Question: What form of chart is displayed?
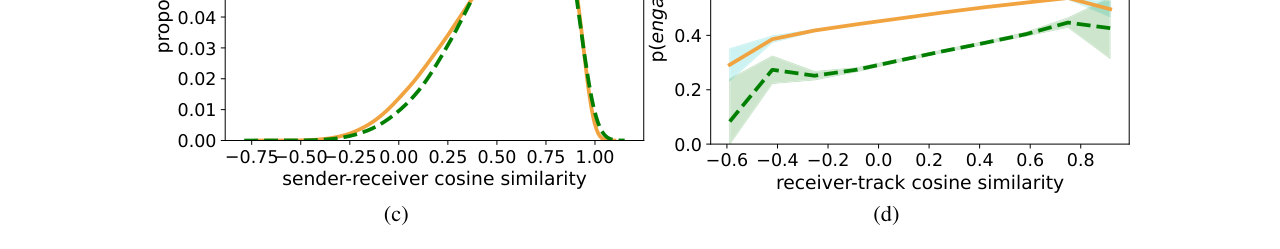
Answer: line